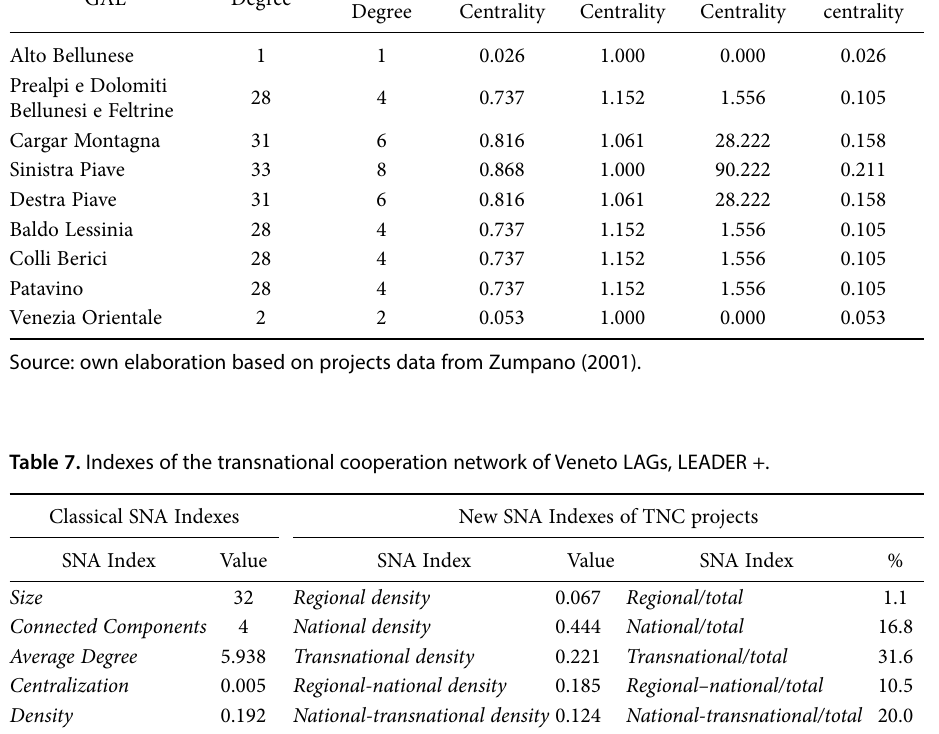
Table 6. Indexes of the transnational cooperation network of Veneto LAGs, by node, LEADER II. GAL Degree